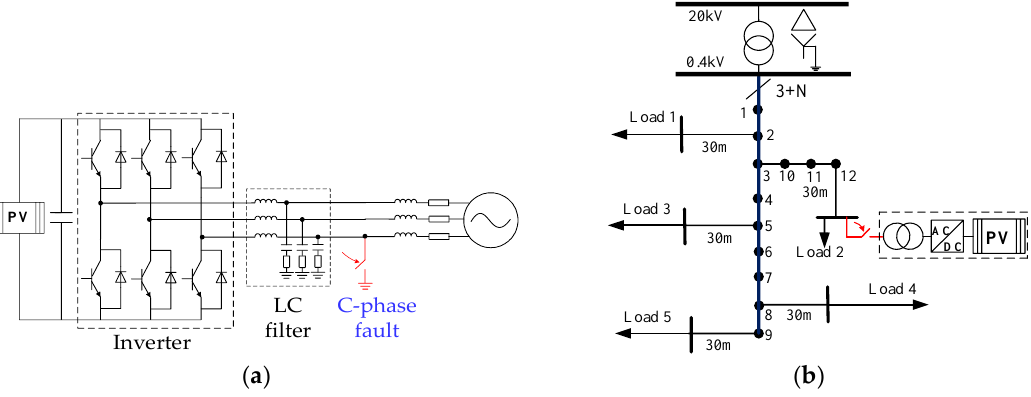
Figure 9. Test cases of the active distribution networks. ( a ) Scenario 1: The PV connected with the infinite bus system. ( b ). Scenario 2: The active distribution network with a PV.